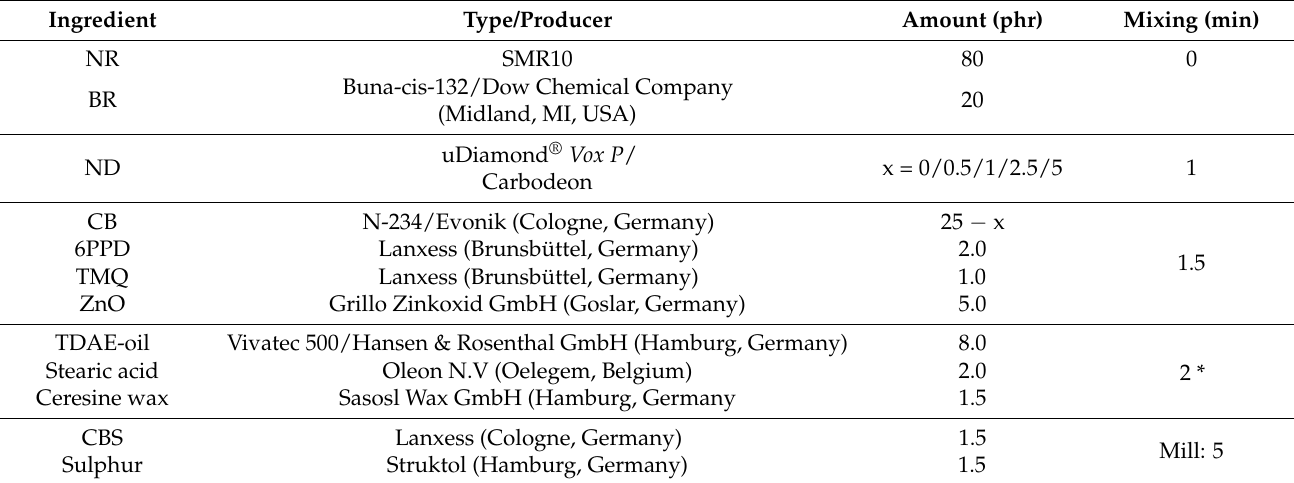
Table 1. The formulation and mixing sequence of the studied rubber